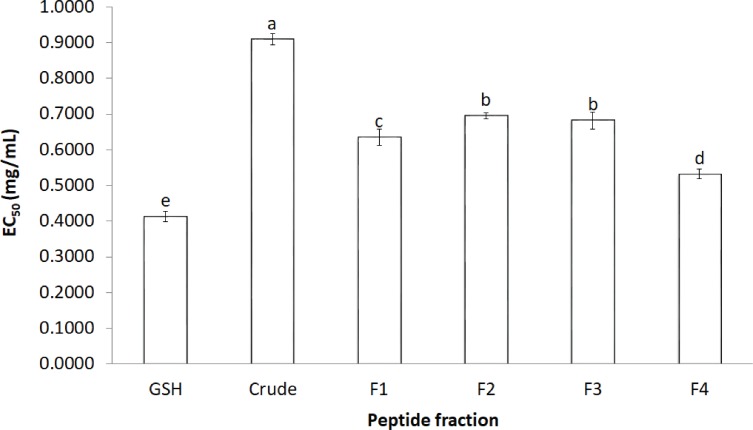
The effective concentration that scavenged 50% (EC50) values for DPPH scavenging activity values of crude-MMPH and its ultrafiltrated peptide fraction.